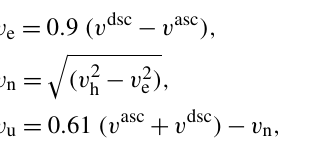
Figure 6. Algorithm of the two-step methodology developed to combine deformation velocities estimated from interferograms and leveling surveys. (1) Three-dimensional geometrical estimation is performed to derive east, north, and vertical components from as- cending and descending InSAR geometries. (2) The vertical com- ponent and leveling data are combined using a weighted regression- kriging